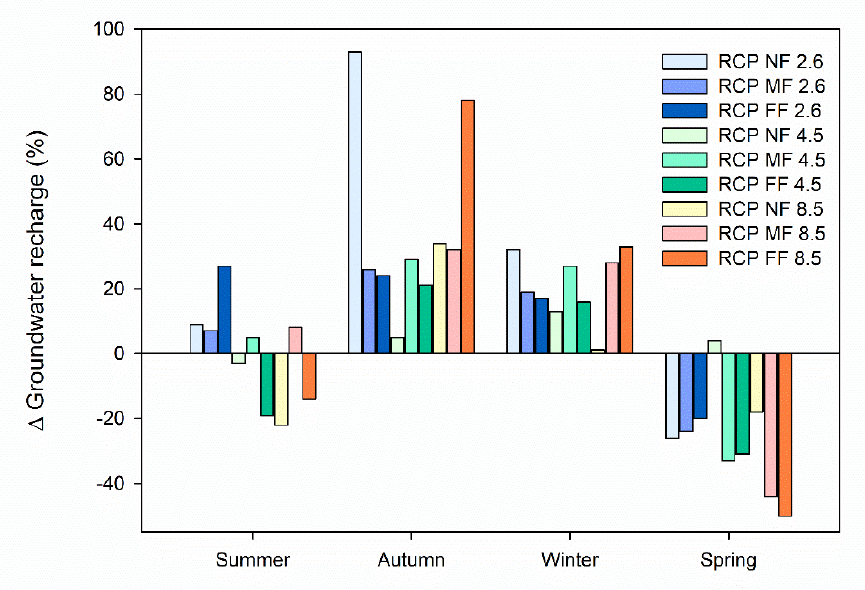
Figure 5. Seasonal groundwater recharge variations for RCP 2.6, RCP 4.5 and RCP 8.5 scenarios.